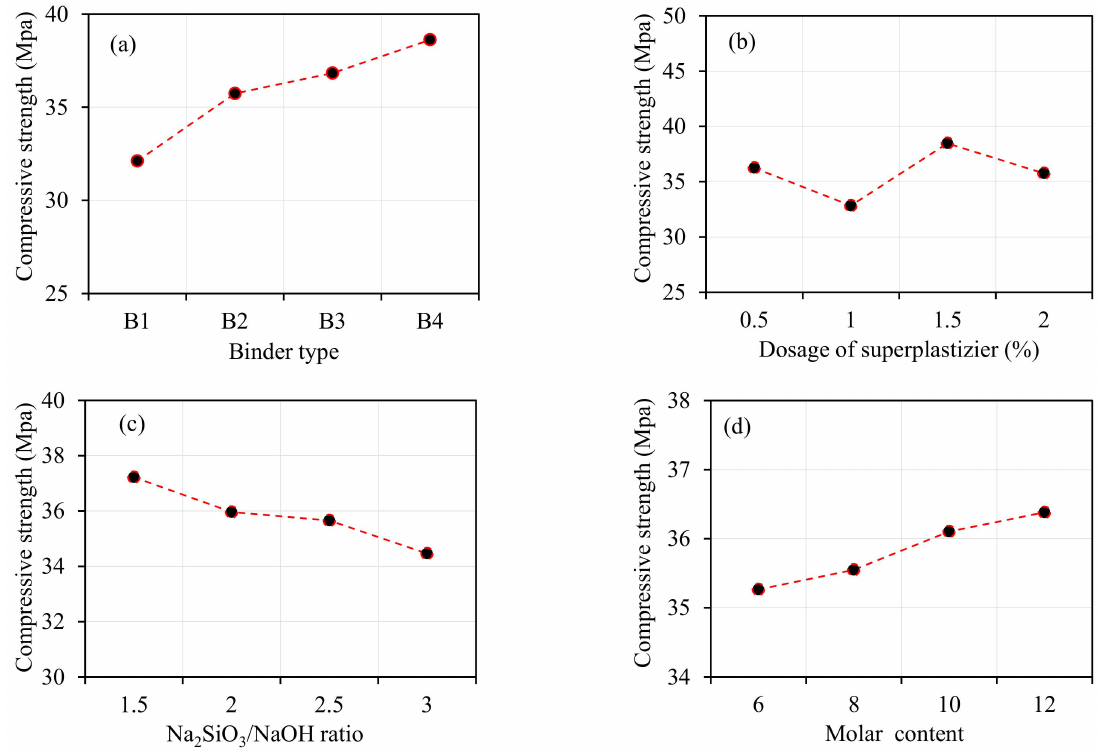
Figure 7. The influence of the investigated parameters on the compressive strength development. ( a ) Binder type; ( b ) Dosage of superplasticizer (%); ( c ) Na 2 SiO 3 /NaOH ratio and ( d ) Molar